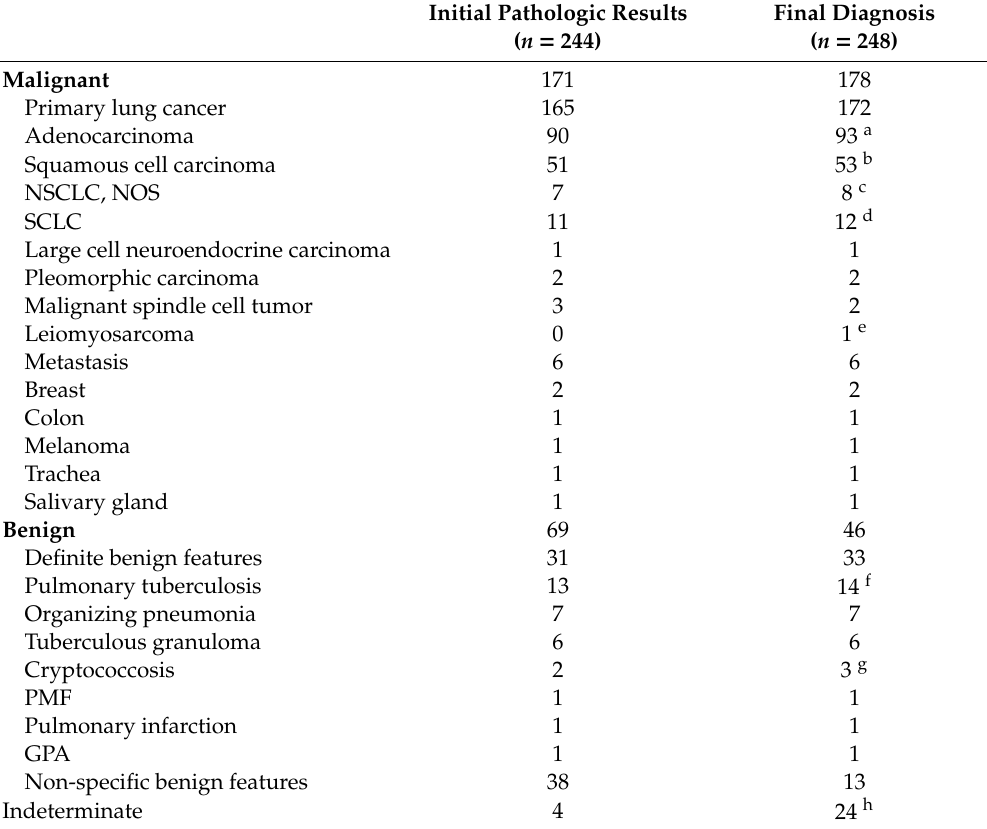
Table 2. Initial pathologic results and final diagnosis.